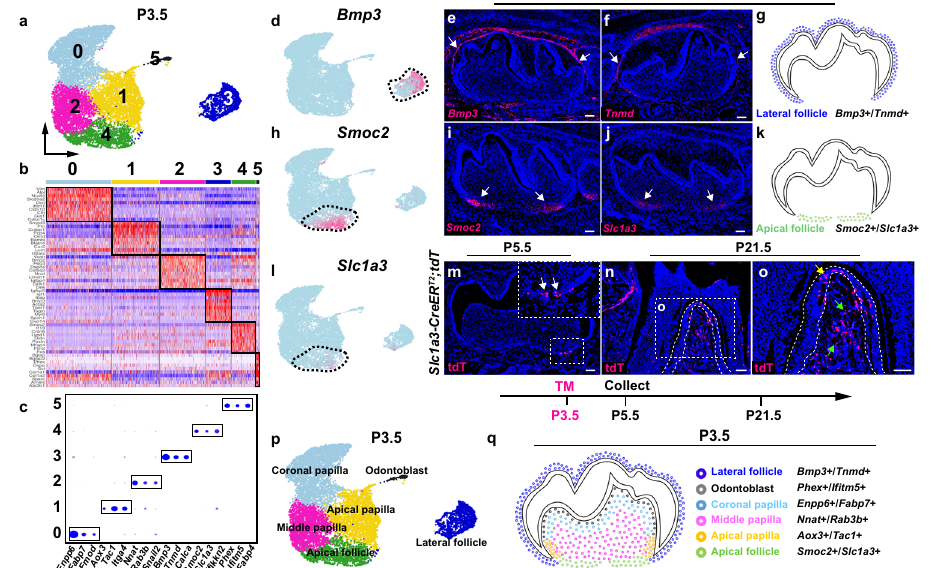
Fig.4|Apicaldentalfolliclecellslargelycontributetotheperiodontaltissuein thefurcationregionofthemouse molar. a UMAPplot ofcellular domains in the mouse molar at P3.5. b , c Heatmap and Dotplot of signature genes of dental mesenchymalcellpopulationsinthemousemolar. d – f FeatureplotandRNAscope staining of lateral follicle markers in the mouse molar at P3.5 ( n =3). g Schematic drawing of the lateral follicle domain in the mouse molar at P3.5. h – j Feature plot and RNAscopestaining ofapicalfollicle markersin the mouse molaratP3.5( n =3). k Schematic drawing of the apical follicle domain in the mouse molar at P3.5. l – o Featureplot of Slc1a3 and lineage tracing analysisofSlc1a3+ cells inthe mouse